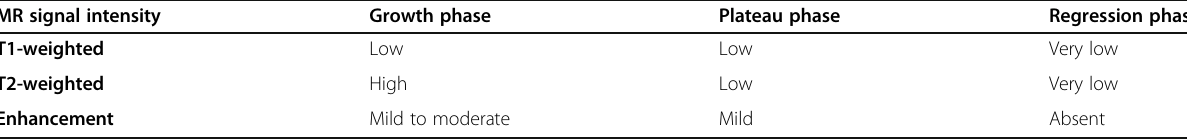
Table 3 MR imaging signal intensity and phases of DTs [3] MR signal